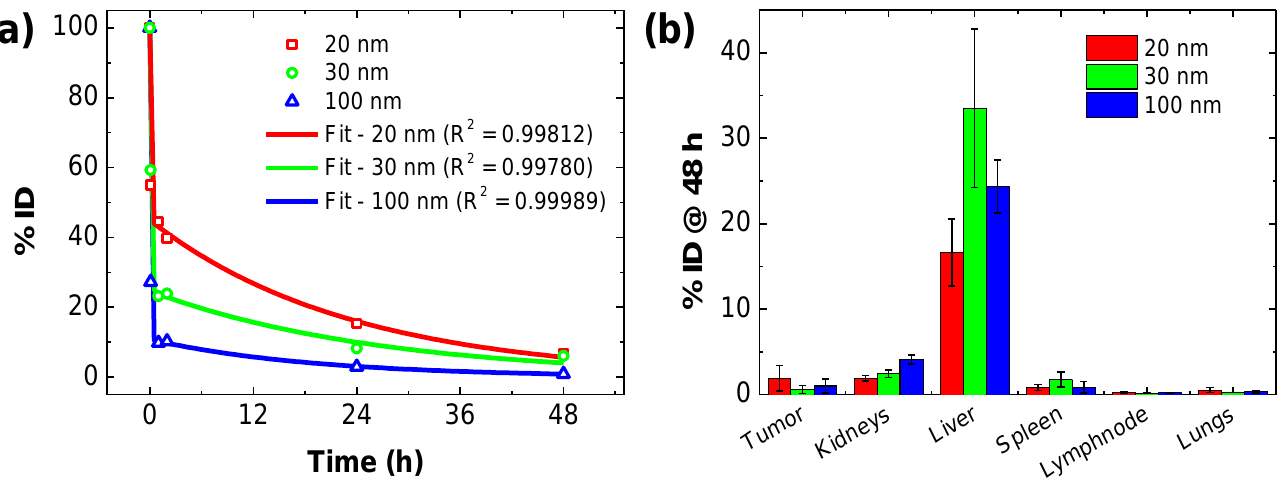
Figure 1. In vivo pharmacokinetic (PK) and ex vivo biodistribution (BD) for bionized nanoferrite ® (BNF ® ) nanoparticles. Except for fitting results, figures are reproduced from data reported by Natarajan et al. [20]. ( a ) Fitting (solid lines) to data using the analytical expression for x b ( t ) (Equation (10)) in text, Materials and Methods) to the in vivo blood PK data obtained from BNF ® nanoparticles having average diameters of 20, 30 and 100 nm. Experimental conditions for blood collection are described in the cited reference. ( b ) Ex vivo biodistribution profiles of BNF ® nanoparti- cles 48 h after injection, as reported in the cited reference. BD data reported as % injected dose (%ID)/g were converted to %ID. Adapted with permission from data previously reported by Natarajan, et al. [20]. Copyright 2008 American Chemical